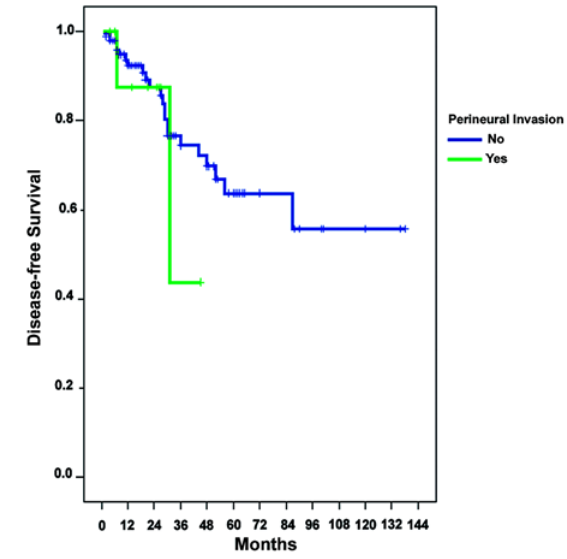
Figure 3 – Cancer-specific survival of patients with and without perineural